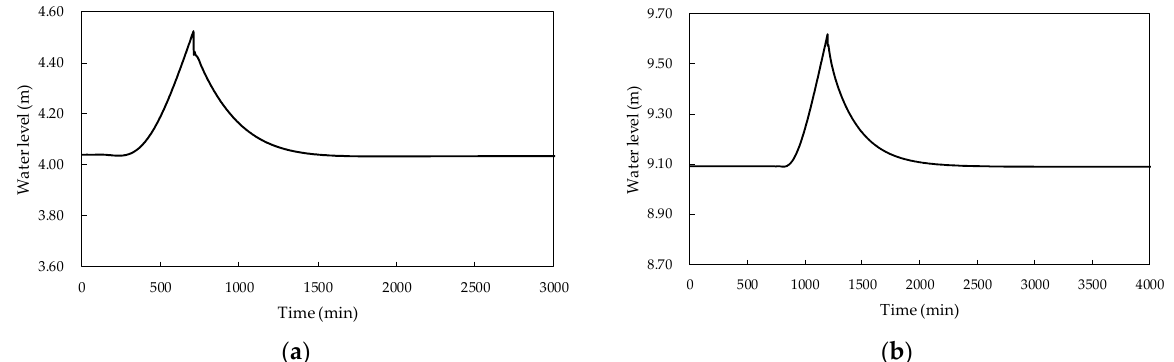
Figure 11. Variation of the water levels immediately upstream of P1 ( a ) and P2 ( b ) when the upstream discharge was increased by 4.4 m 3 /s.